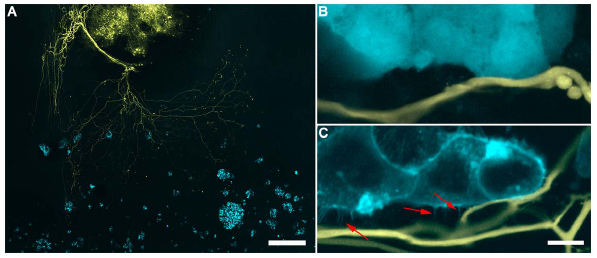
Figure 1. LNCaP cells that overexpress beta-2 generate microprocesses towards nerve while vector control LNCaPs do not. A . A tile scan of 2BECFP cells (blue) in co-culture with a YFP + spinal slice (yellow) displays prostate cancer cells in close proximity to YFP + nerve axons (scale bar = 500 m m). B . LNCaP vector control LNECFP cells can be closely positioned to spinal cord axons (scale bar = 10 m m). C . 2BECFP cells exhibit what appears to be a membrane- specific CFP fluorescence and most notably, beta-2 specific microvilli (red arrows, scale bar = 10 m m).